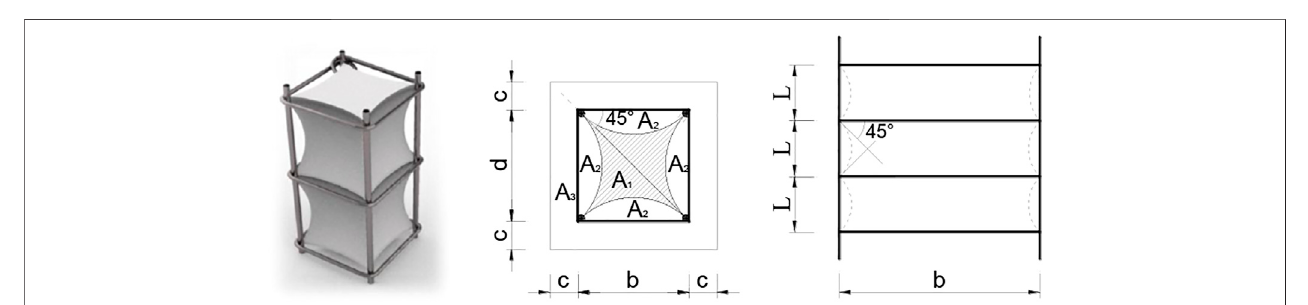
FIGURE 11 | Schematic diagram of restraint partition of RC